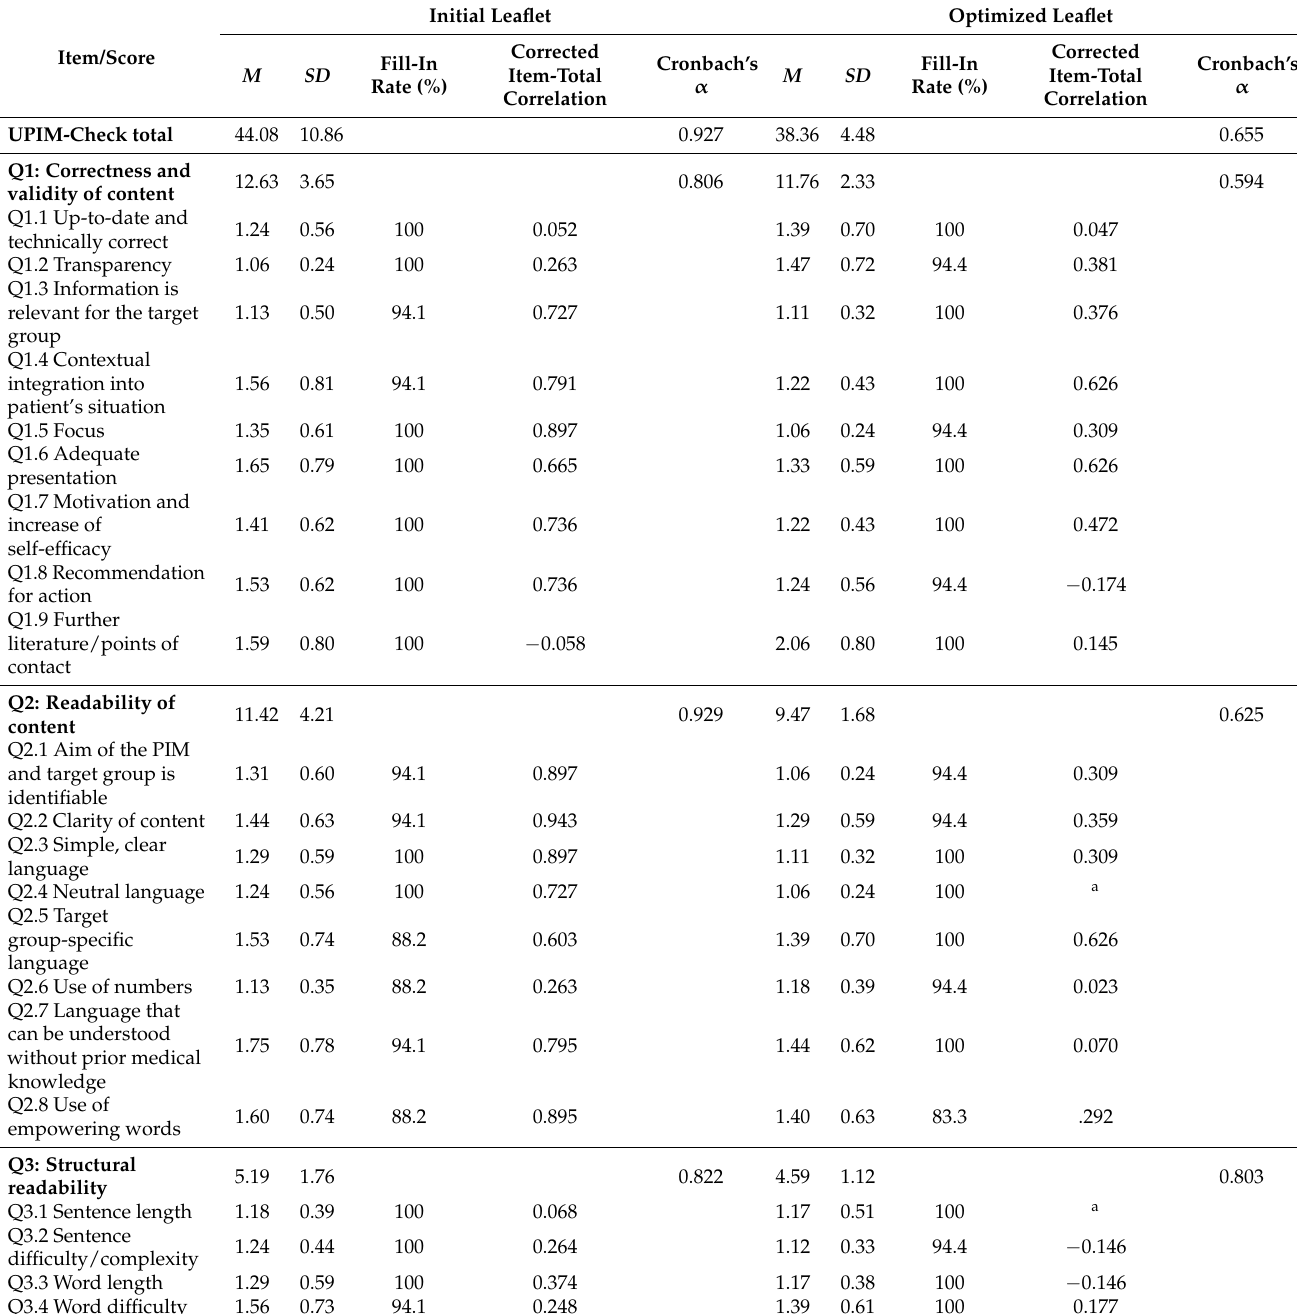
Table 2. Item and score characteristics of the UPIM-Check German version according to the rating of the initial and optimized